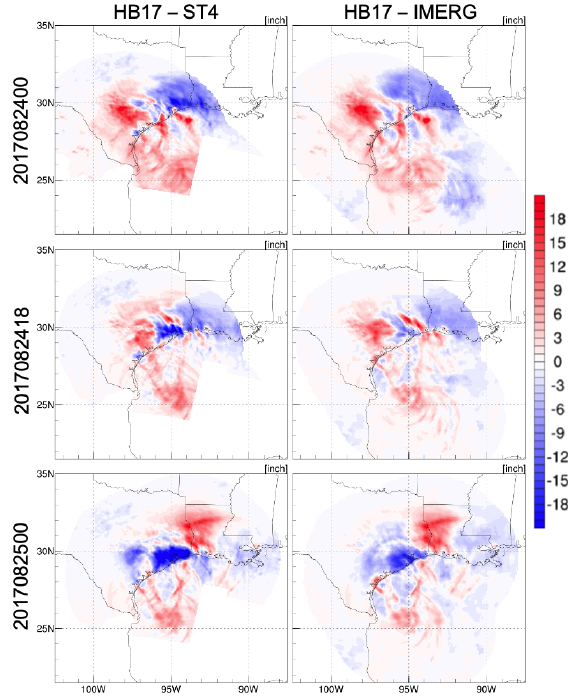
Figure 4. Rain swath difference between HB17 and observational datasets. The difference between HB17 and Stage IV data are shown in the left panels. The right panels show the different plots of HB17 and IMERG. Red indicates overestimation from the HB17 model and blue is underestimation.